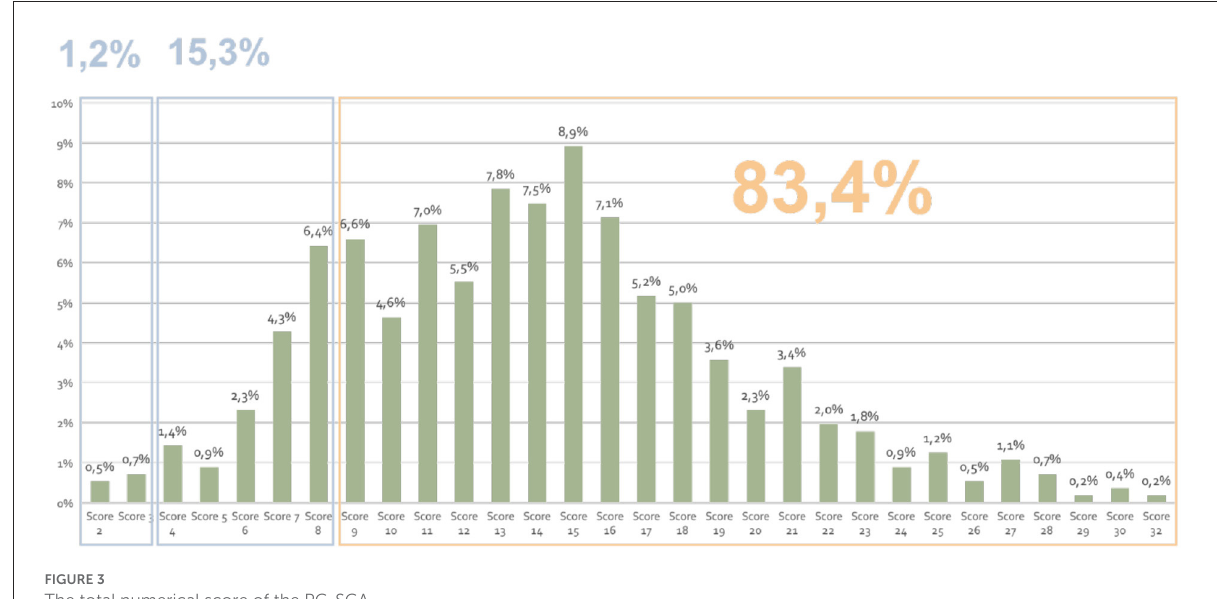
FIGURE3 The total numerical score of the